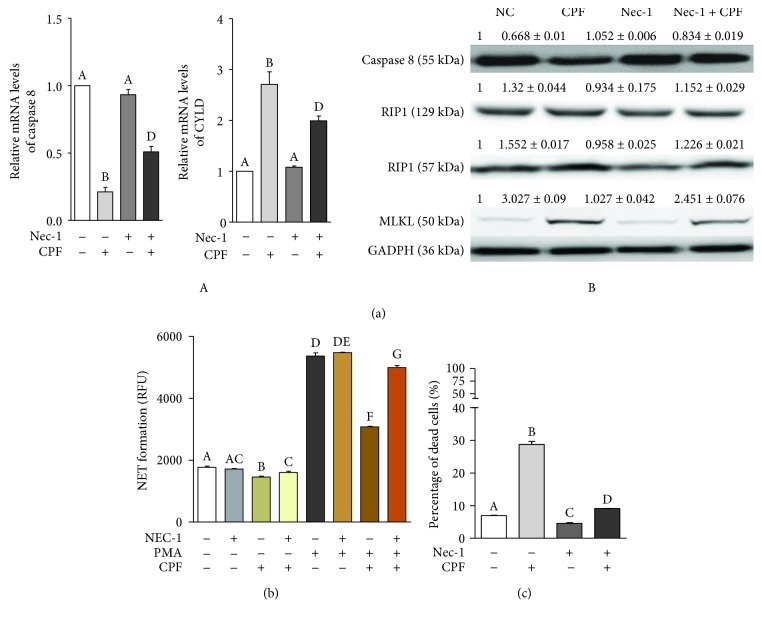
Detection of necroptosis, production of NETs, and the percentage of dead cells (%) according to fluorescence microscopy of neutrophils after various treatments. (a) The mRNA (A) and protein (B) levels of the genes related to necroptosis. The experiments were repeated three times. The data are presented as the mean ± SD. Samples with different letters were considered significantly different (P < 0.05). (b) Production of NETs in neutrophils after various treatments. Neutrophils were treated with various reagents including PMA, CPF, and Nec-1; the formation of NETs was detected by a fluorescence spectrophotometer. The experiments were repeated three times. Quantitative data are presented as the mean ± SD. Samples with different letters were considered significantly different (P < 0.05). The samples with the same letters were not significantly different (P > 0.05). (c) Percentage of dead cells (%) according to fluorescent microscopy. The percentages of dead cells in the NC, CPF, Nec-1, and Nec-1+CPF groups determined by fluorescence microscopy were calculated and are shown in the figure. The percentage of dead cells in a descending order: CPF, Nec-1+CPF, NC, and Nec-1 groups. The data are presented as the mean ± SD. Bars with different letters were considered significantly different (P < 0.05).